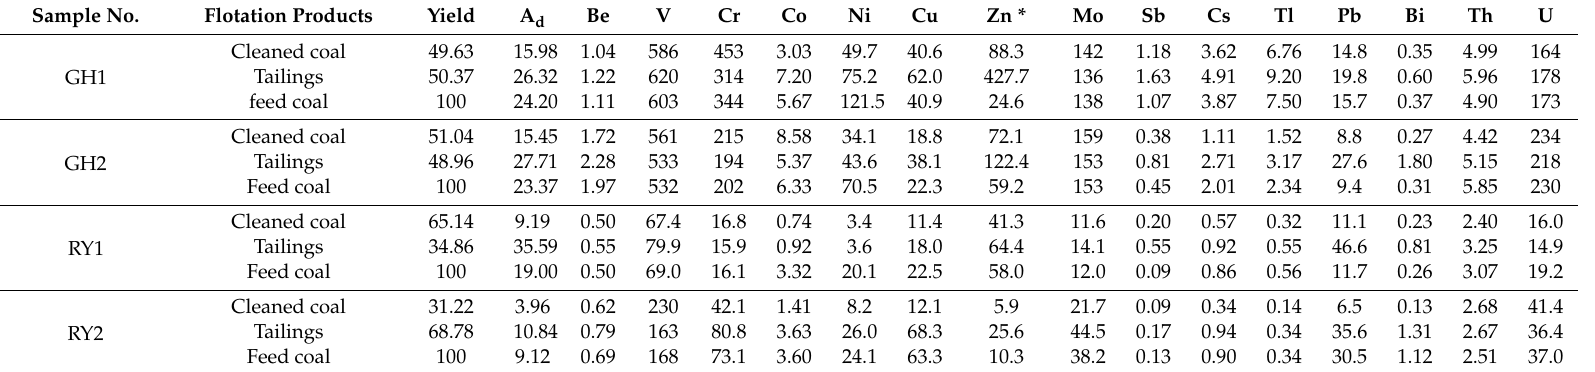
Table 5. The yield (%), ash yield (%), and contents of toxic trace elements in flotation products ( µ g/g). Sample